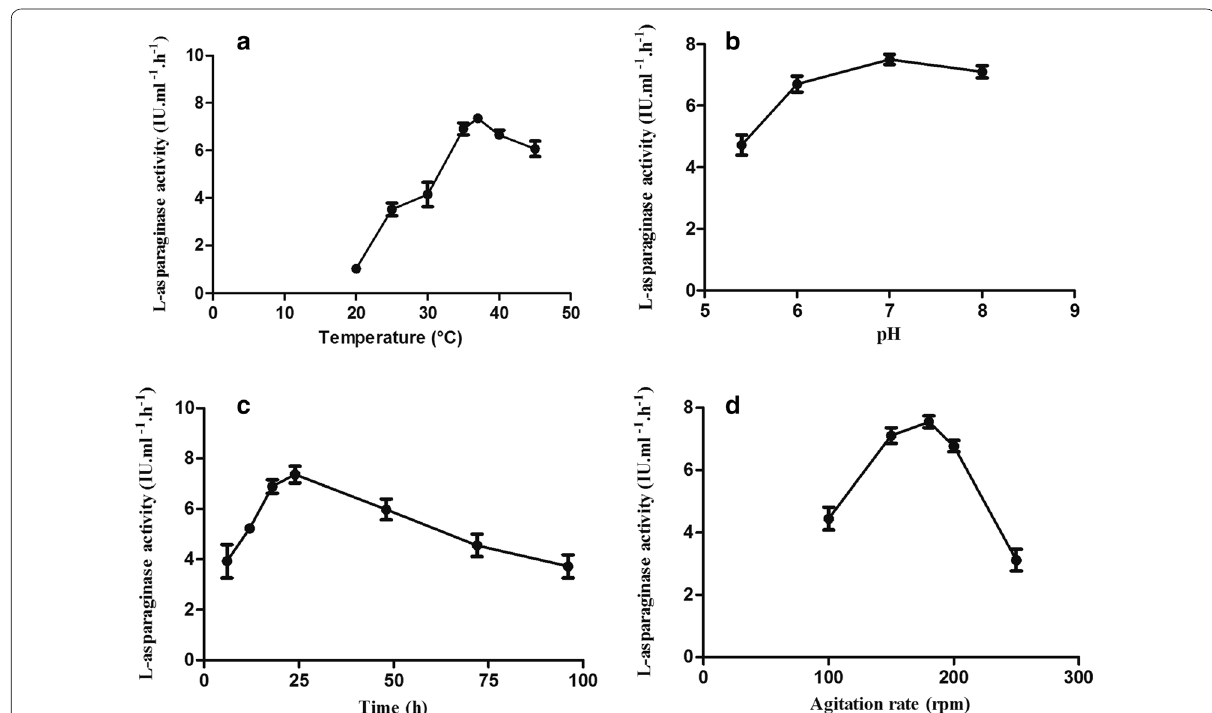
Fig. 4 l -asparaginase production by Stenotrophomonas maltophilia EMCC2297 variant at different temperatures of incubation ( a ), initial pH values ( b ), incubation periods ( c ) and rates of agitation ( d